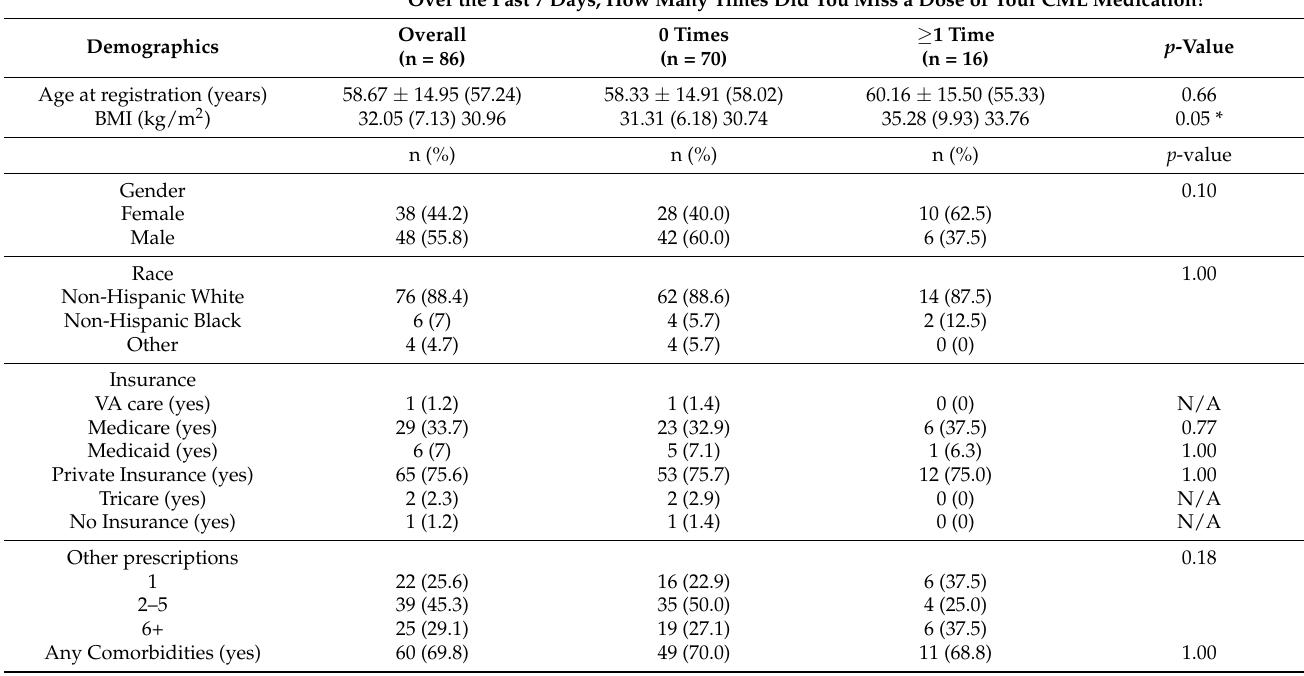
Table 1. General demographics and medication adherence among patients with chronic myelogenous leukemia (CML) who were prescribed oral chemotherapy.